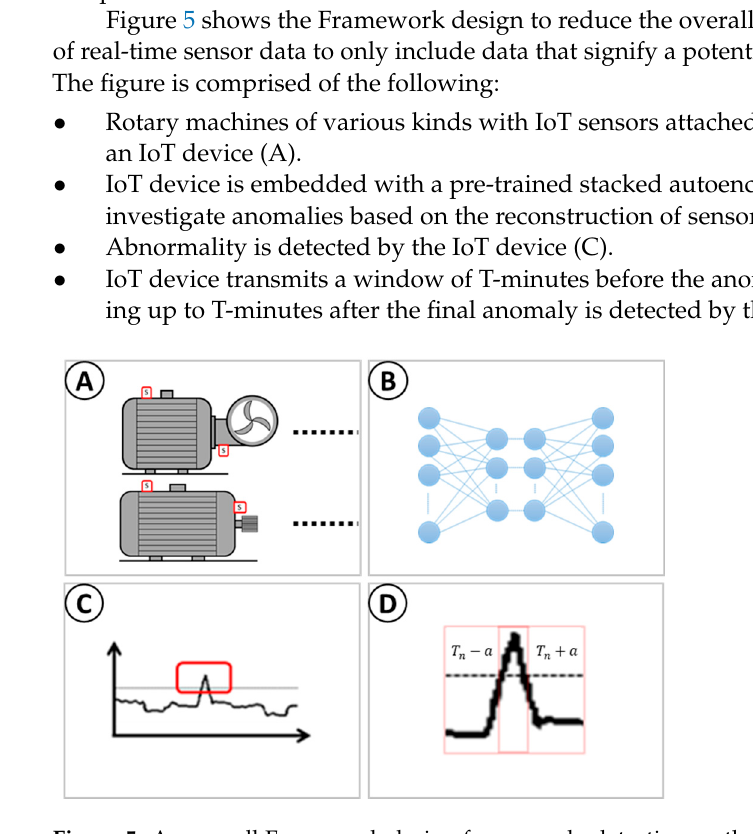
Figure 5. An overall Framework design for anomaly detection on the edge for data transmission. ( A )—refers to the transmission of sensors to motors, pumps, or fans. ( B )—refers to the application of a machine learning model to the sensor data, to detect normal running conditions. ( C )—refers to the detection of a window of data, with an error above normal conditions. ( D )—refers to the transmission of the window of data, both before and after the abnormality is detected.